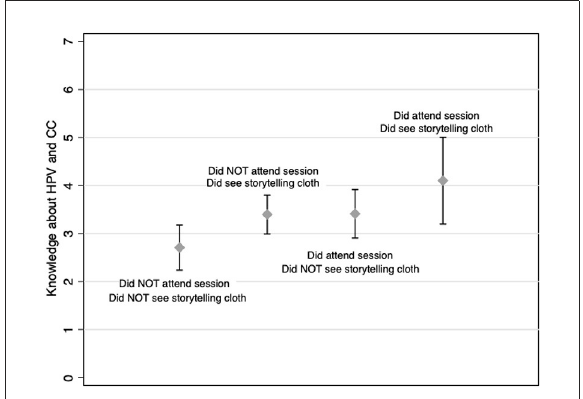
FIGURE2 Predicted knowledge level by education session attendance and story-telling cloth viewing. Knowledge about STIs, cervical cancer and HPV. Study participants ( N = 500) were asked if they knew what an STI (sexually transmitted disease) was and questions assessing their knowledge about CC and HPV were asked. The relationship (using the regression described in the text) for each of the variables under study is reported in the graphs for all participants. 95% confidence intervals are illustrated for each category. This graph demonstrates women who had neither attended an education session nor seen the story-telling cloth only scored a 2.7 on the knowledge scale, while women who had both attended a session and seen the story-telling cloth scored 4.1 on average. Importantly, there is no overlap in the confidence intervals of these two predictions suggesting that overall knowledge of CC and the link between HPV and CC was increased by exposure to the story-telling cloth